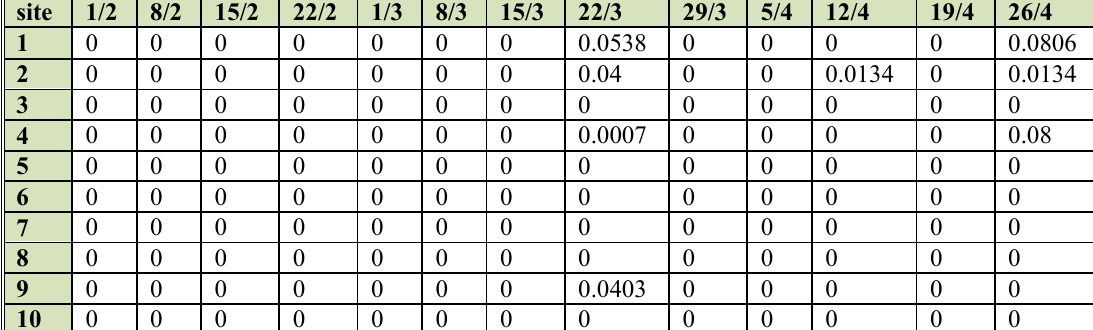
Table 10: Fe values